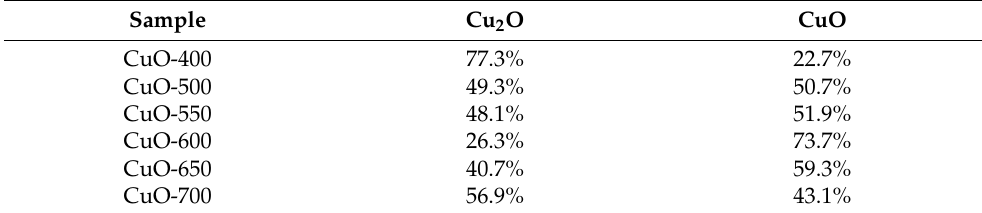
Figure 2. XRD patterns of Cu foils oxidized at different temperatures for 2 h. Table 2. The composition of oxide species on the surface of Cu foil.